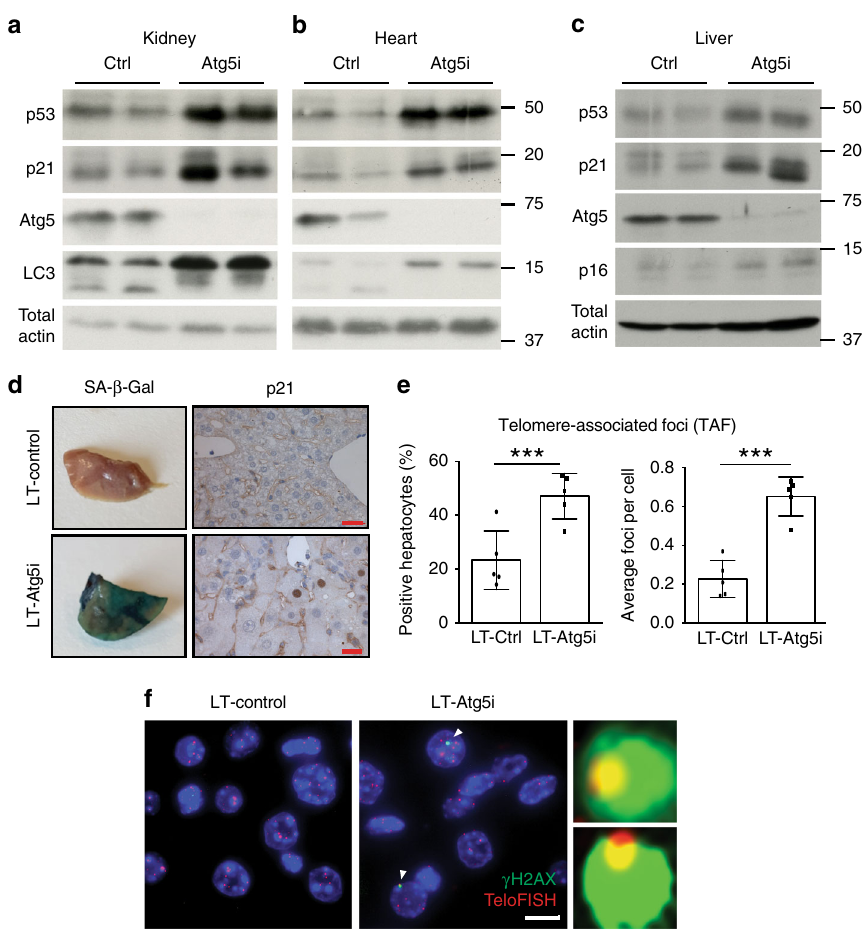
Fig. 3 Autophagy inhibition drives senescence in vivo. Markers of senescence can also be seen across multiple tissues in our LT-Atg5i cohorts treated with dox for 4 months including in kidney ( a ), heart ( b ), and liver ( c ). LT-Atg5i livers stain positively for senescence associated β -galactosidase and p21 unlike age-matched control mice ( d ) (scale bar, 25 μ m). e 6-month doxycycline treated LT-Atg5i livers display an increase in the frequency and abundance of γ -H2AX at telomeres, a marker associated with increasing chronological age (unpaired two-tailed t test; n = 5). f A representative example image shown. Arrowheads point to TAF that are magni fi ed on the right of the image. Scale bar, 10 μ m. Error bars indicate standard deviation *** p < 0.001. For a – c source data are provided as a Source Data fi